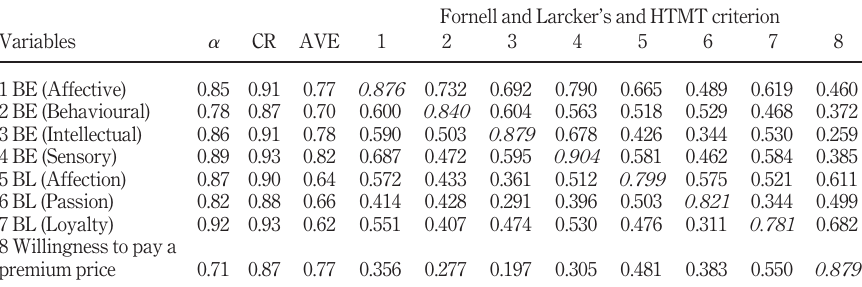
Table 1. Reliability, convergent and discriminant validity